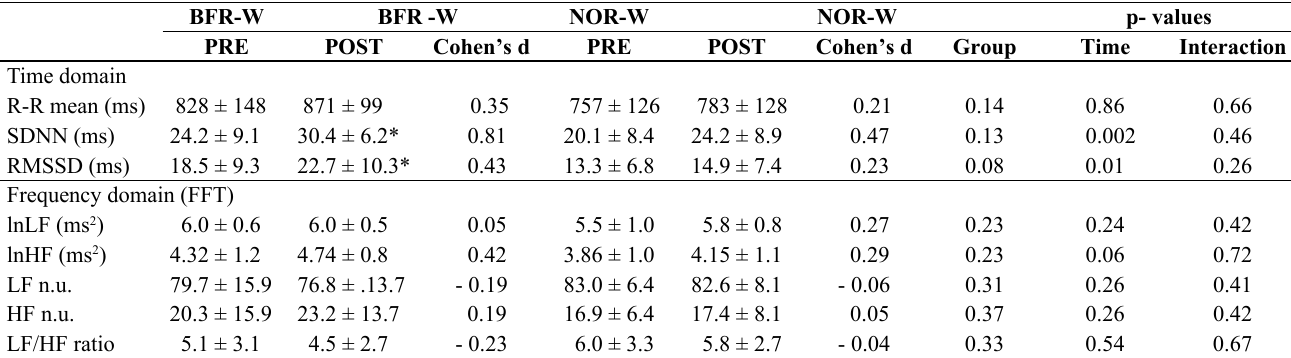
Table 2. Changes on resting HRV parameters after 6-week of walk training with or without blood flow restriction. BFR-W BFR -W NOR-W NOR-W p- values PRE POST Cohen’s d PRE POST Cohen’s d Group Time